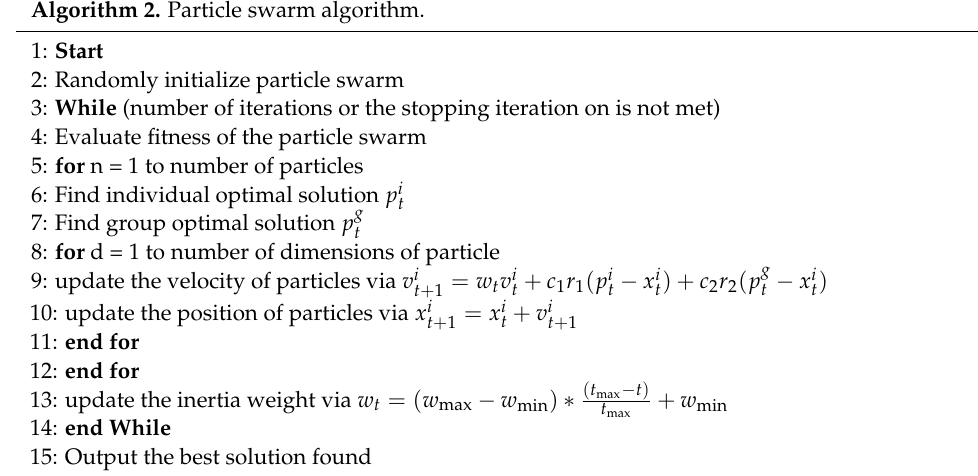
Algorithm 2. Particle swarm